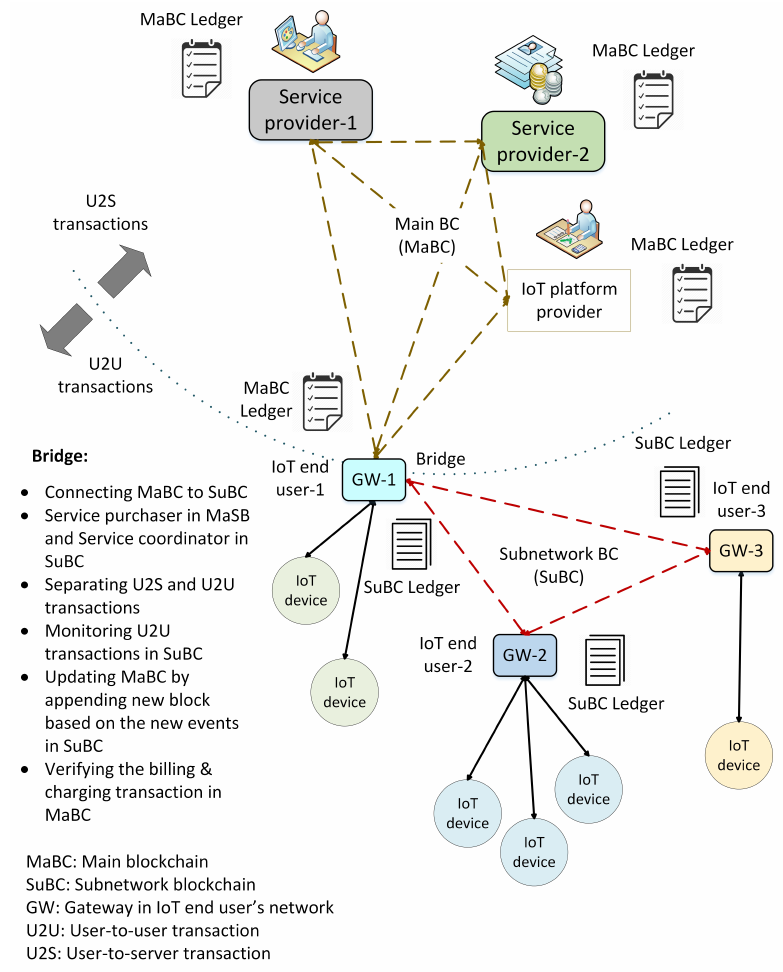
Figure 3. Proposed hybrid blockchain consists of a main blockchain for billing and charging transactions and subnetwork blockchains for P2P